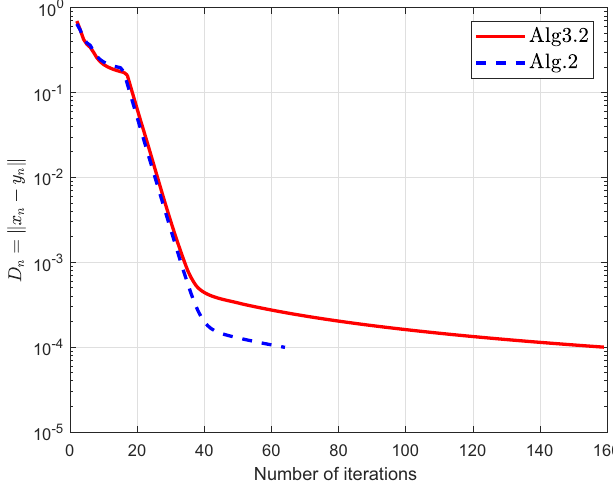
Figure 3: Example 6.1: Comparison of Algorithm 2 with Algorithm 3.2 in [ 31 ] .